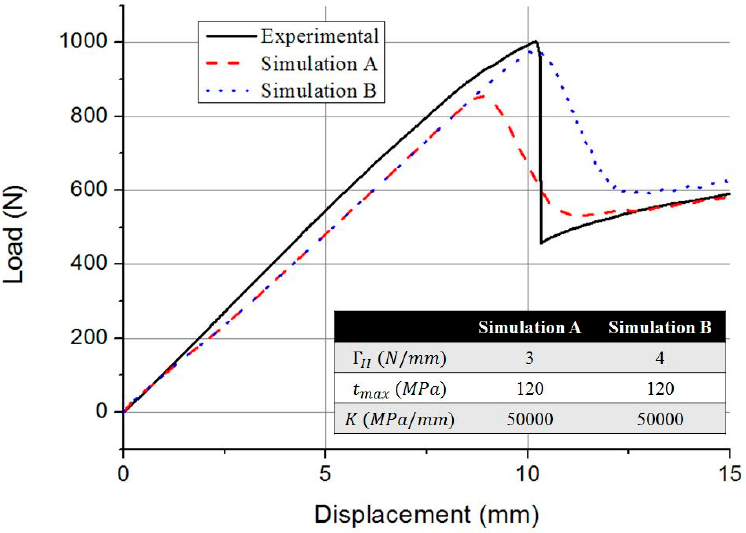
Figure 4. Experimental and simulation results with single cohesive zone (W3).